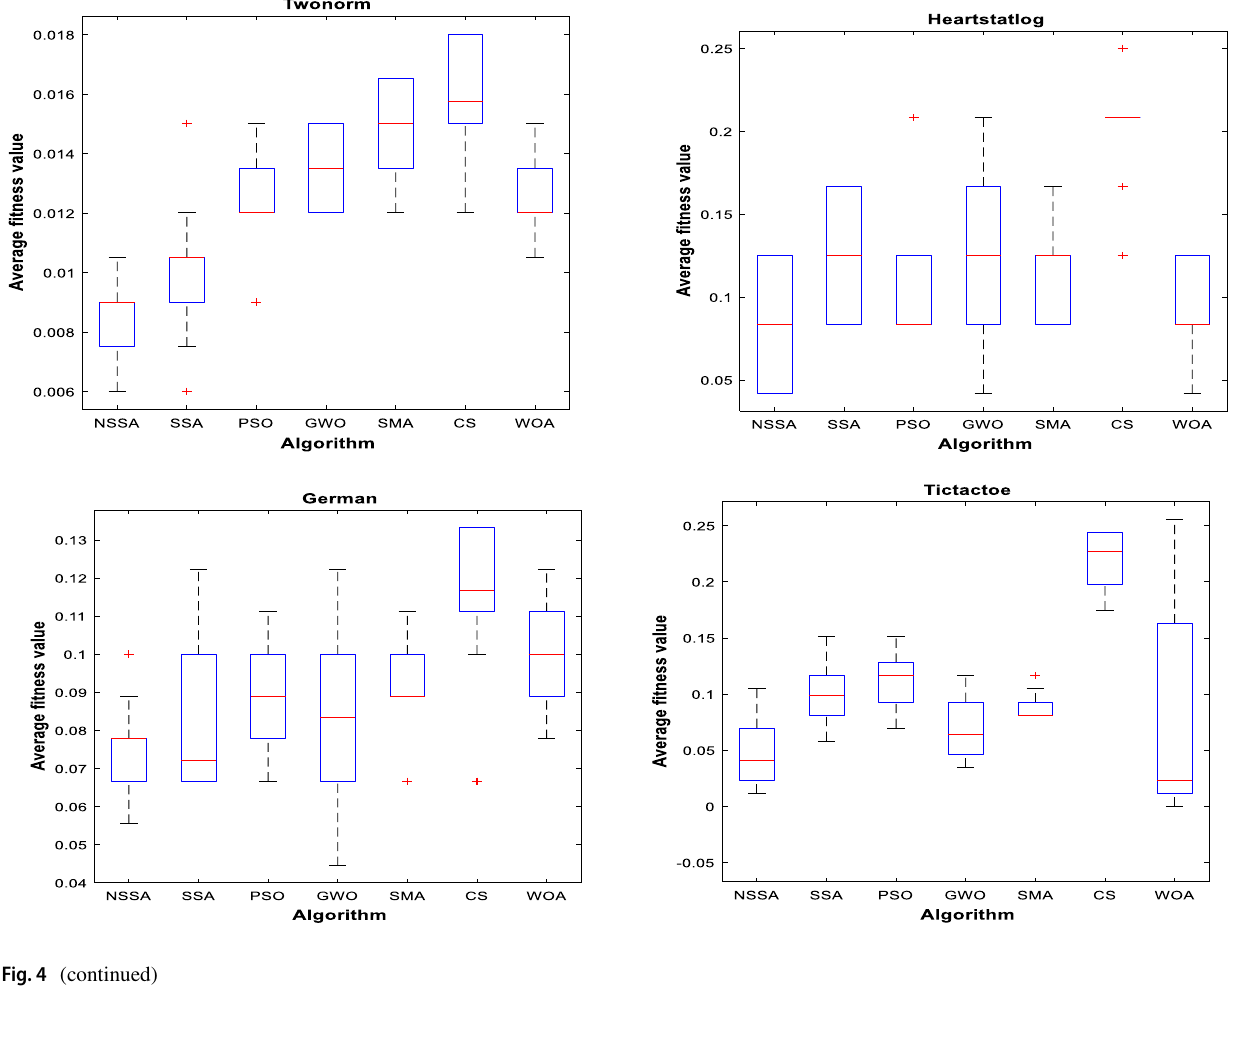
Fig. 5 Average accuracy of classification dataset during